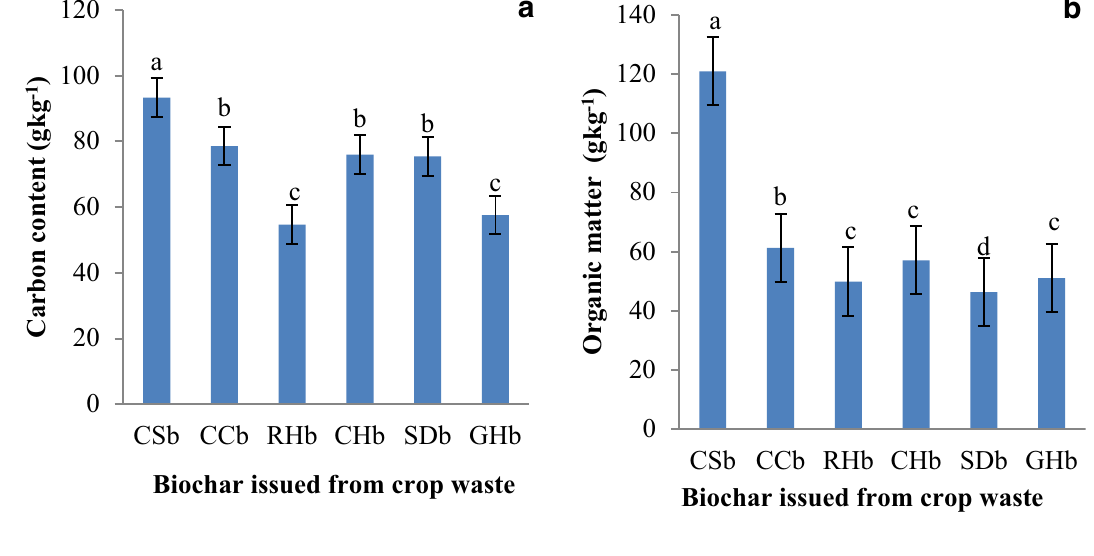
to Tukey test at P > 0.05. CSb cassava biochar, CCb corncob biochar, RHb rice husk biochar, CHb coffee husk biochar, SDb saw dust bio- char, GHb groundnut husk